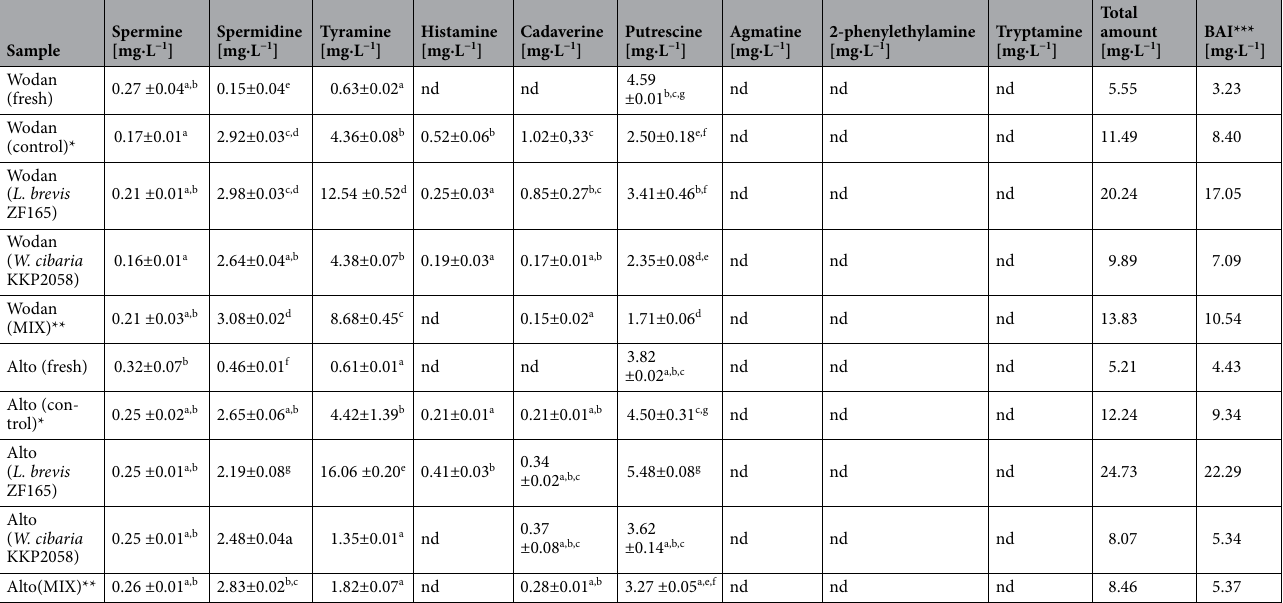
Table 4. Content of biogenic amines and the calculated BAI values for the fresh and fermented red beet juices of Wodan and Alto variety. *Control: spontaneous fermentation. **MIX: L. brevis ZF165; W.